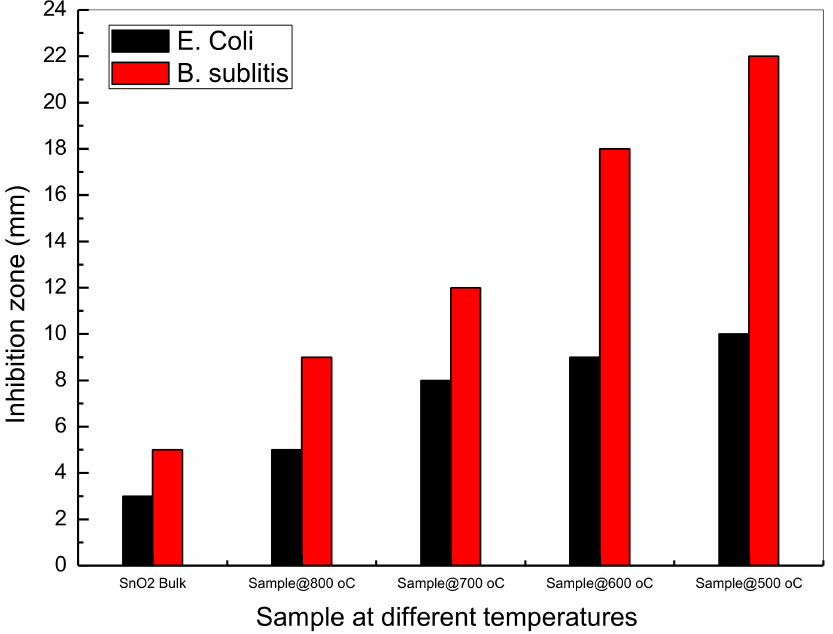
Figure 12. Average inhibition zone graph for SnO 2 bulk and SnO 2 nanoparticles against Escherichia coli ATCC 25922 Gram ( − ve ) and Bacillus subtilis UPMC 1175 Gram (+ ve )